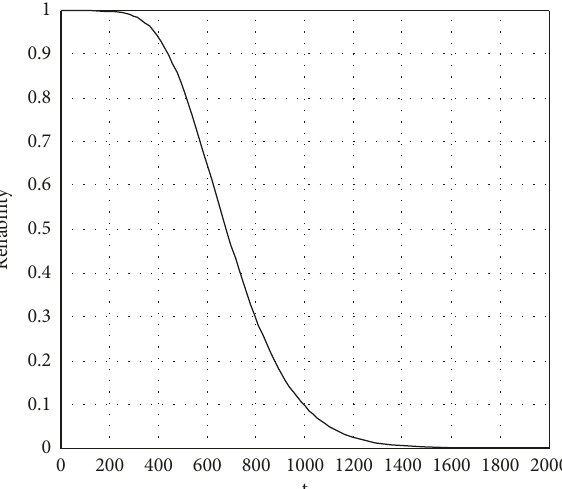
Figure 16: The curve of the system reliability R ( t ) .